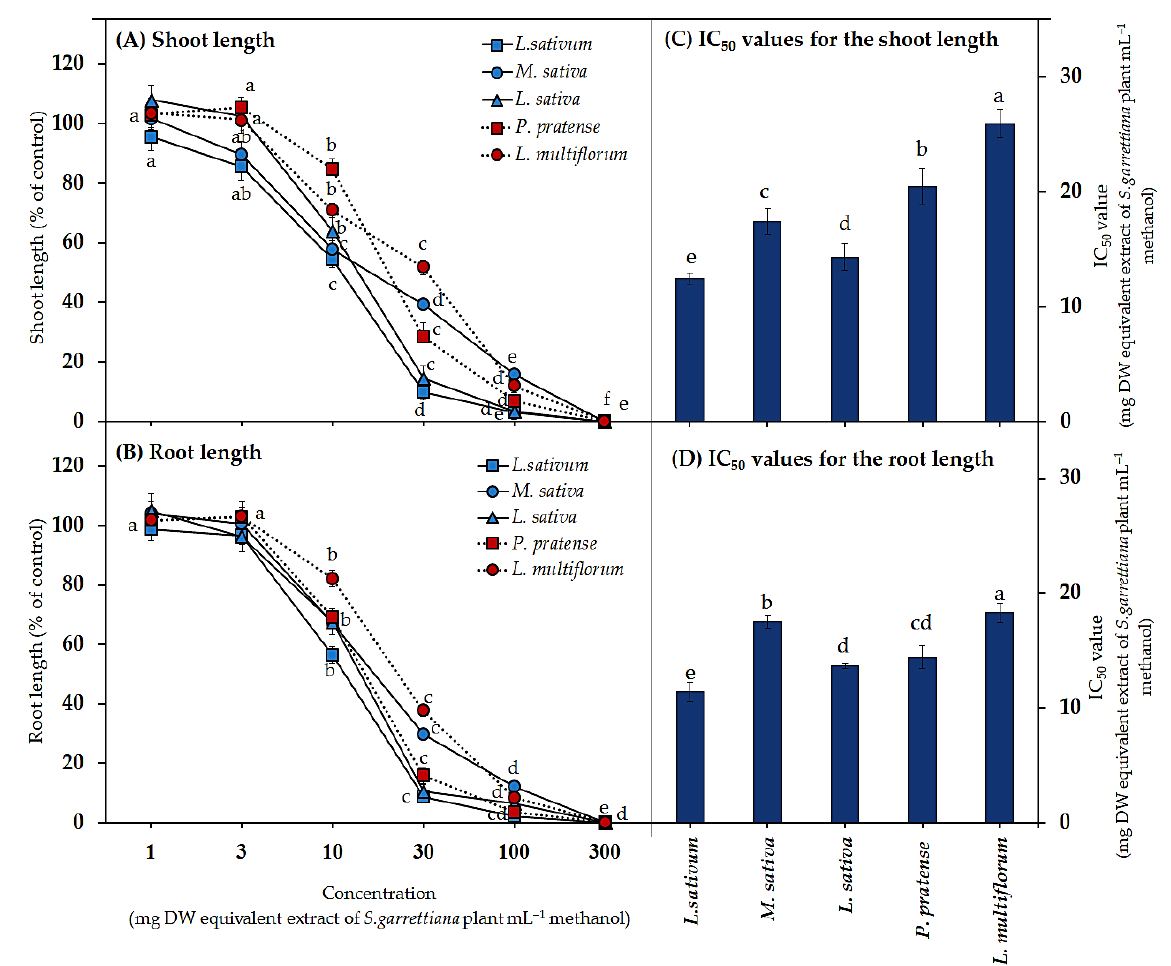
Figure 2. Biological activities of the S. garrettiana leaf extracts: effects on the ( A ) shoot and ( B ) root length of five test plants, and the IC 50 values for ( C ) the shoot and ( D ) root length. The values are means ± SD from three replicates, each with 10 seedlings; different letters on the bars indicate statistically significant differences between treatments (Tukey’s HSD; p ≤ 0.05).